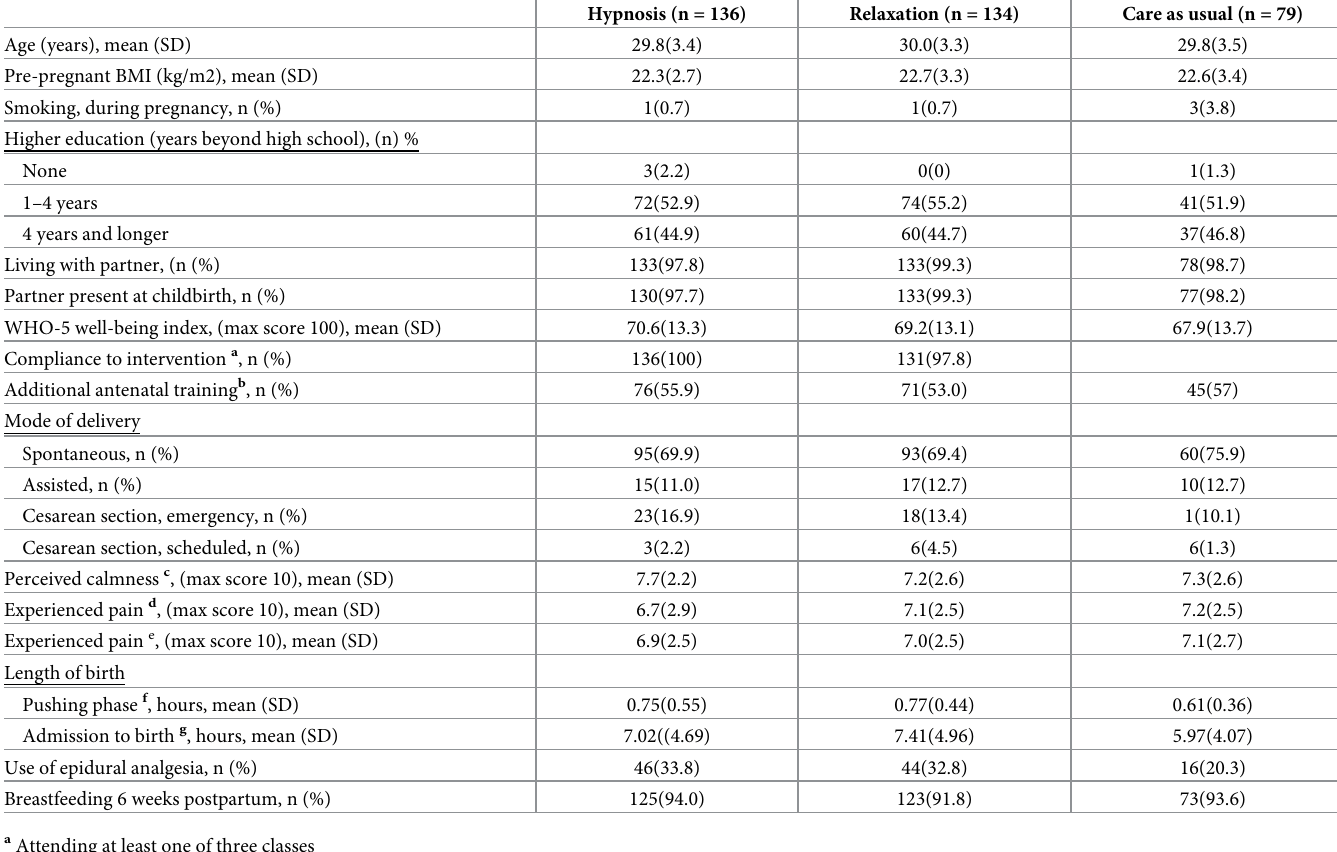
Table 1. Participant